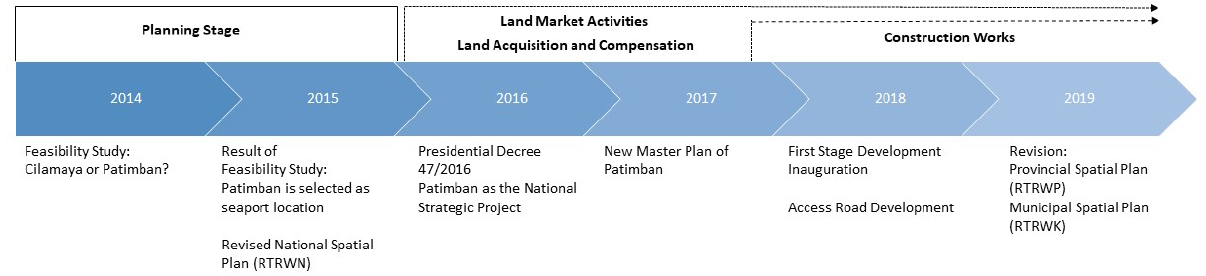
Figure 3. Project Timeline (own representation).